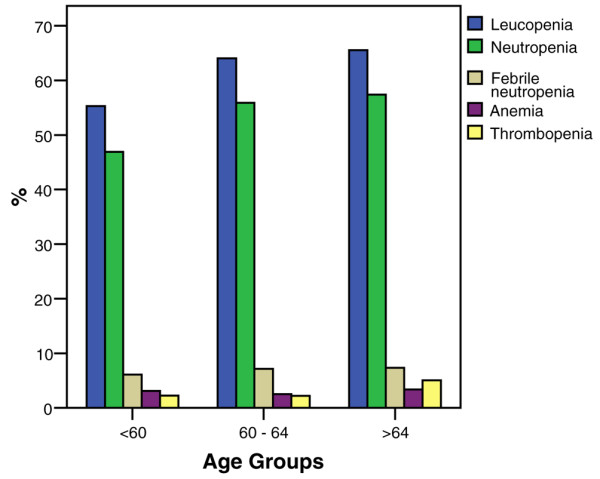
Incidences of grade 3 and grade 4 hematologic adverse events versus age group. Leucopenia: age <60 years, n = 1,730; age between 60 and 64 years, n = 406; age >64 years, n = 272 (P < 0.001). Neutropenia: age <60 years, n = 1,152; age between 60 and 64 years, n = 326; age >64 years, n = 225 (P < 0.001). Febrile neutropenia: age <60 years, n = 181; age between 60 and 64 years, n = 43; age >64 years, n = 29 (P = 0.430). Anemia: age <60 years, n = 97; age between 60 and 64 years, n = 16; age >64 years, n = 14 (P = 0.674). Thrombopenia: age <60 years, n = 70; age between 60 and 64 years, n = 14; age >64 years, n = 21 (P = 0.002).